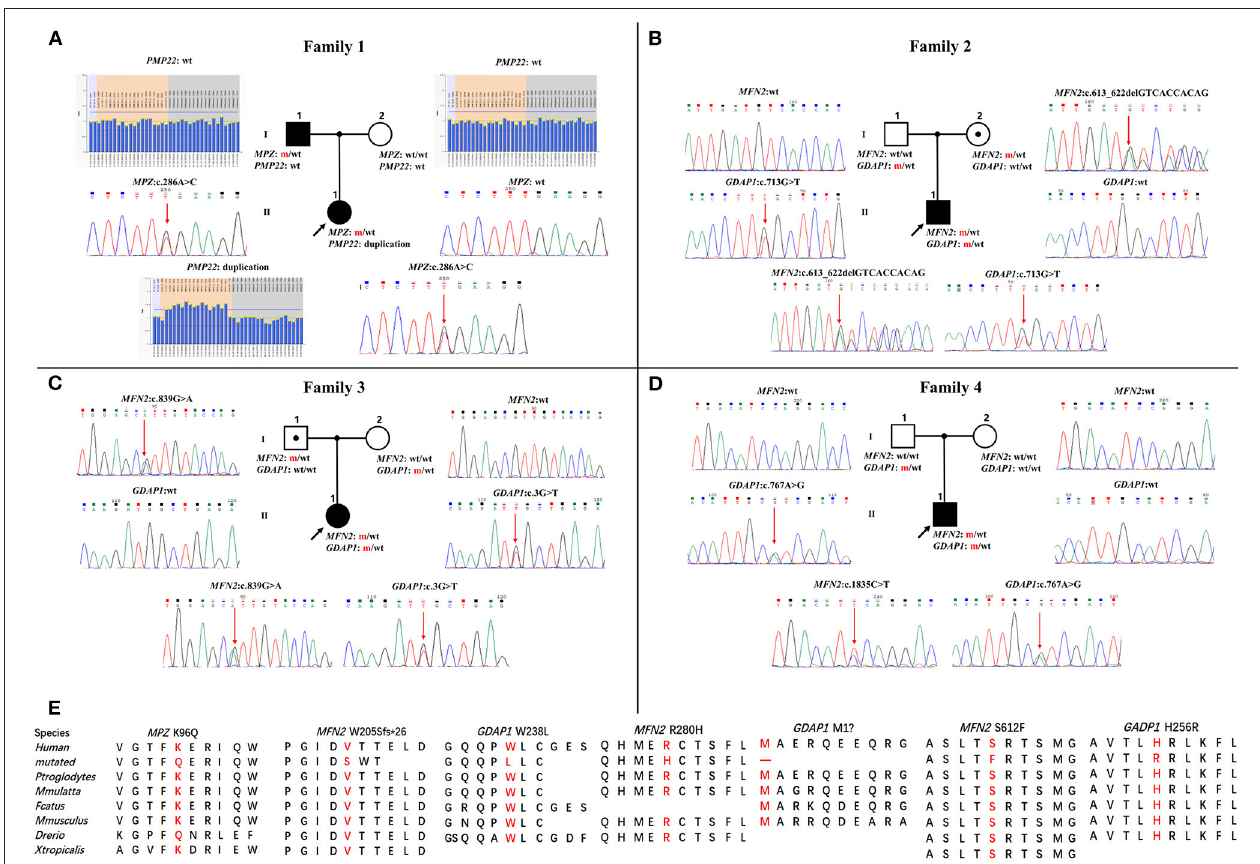
FIGURE 1 | Pedigrees and genomic sequencing results are shown for 4 families with concomitant variants. (A) The proband in family 1 has a PMP22 duplication and an MPZ c.286A > C (p.K96Q) variant. (B) The proband in family 2 has a combination of heterozygous variants in MFN2 (c.613_622delGTCACCACAG, p.V205Sfs*26) and GDAP1 (c.713G > T, p.W238L). (C) The proband in family 3 possessing heterozygous variants in MFN2 (c.839G > A, p.R280H) and GDAP1 (c.3G > T, p.M1?). (D) The proband in family 4 with de novo heterozygous MFN2 c.1835 C > T (p.S612F) variant and heterozygous GDAP1 c.767A > G (p.H256R) variant. Clinical status: open symbols, unaffected family members; filled symbol, patients; black dot in open symbols, subclinical subjects with electromyographic or clinical examination perturbation; the black arrow, proband; wt, wild-type alleles; m, mutated alleles; the red arrow, mutated sites. (E) Conservation of amino acids at mutation sites in the different